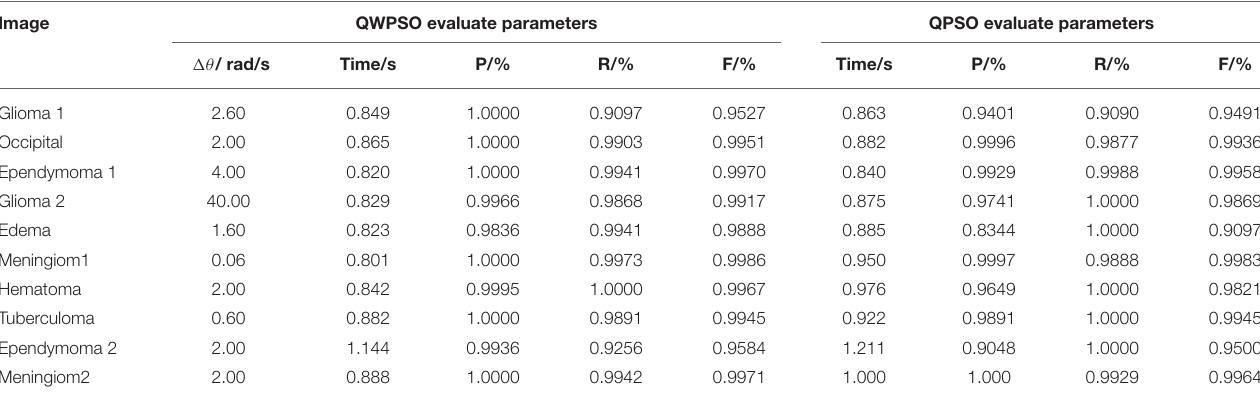
TABLE 2 | Evaluation of parameters in test